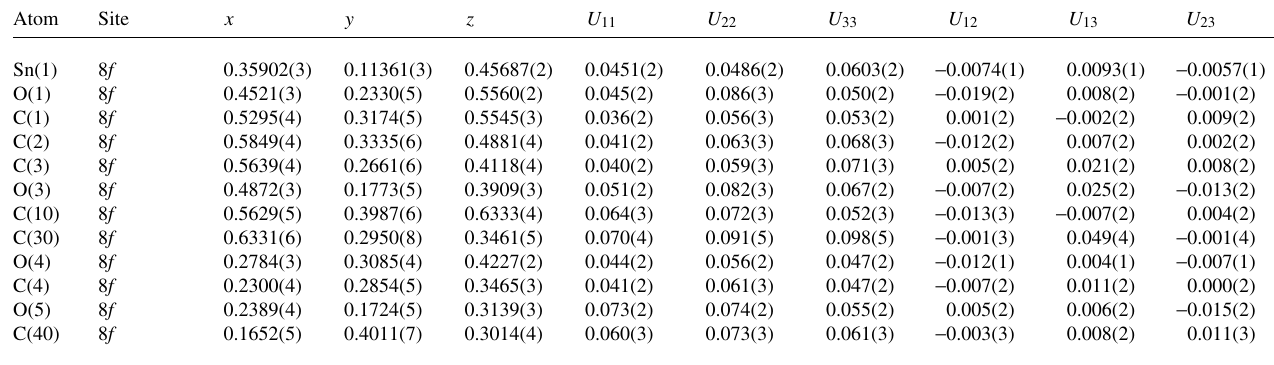
Table 3. Atomic coordinates and displacement parameters (in Å 2 )